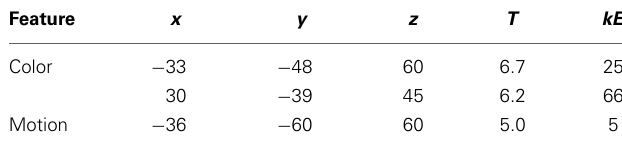
Table 2 | Peak voxel coordinates given in MNI space, significance (T), and cluster size (kE) of all areas showing concept associated activity in posterior parietal cortex.